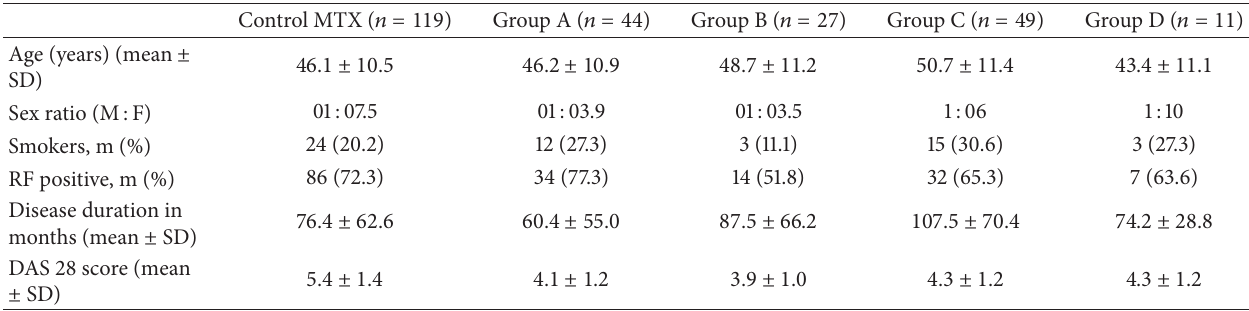
Table 1: Demographic profile of patients grouped according to methotrexate dose. Control MTX ( 𝑛 = 119 )